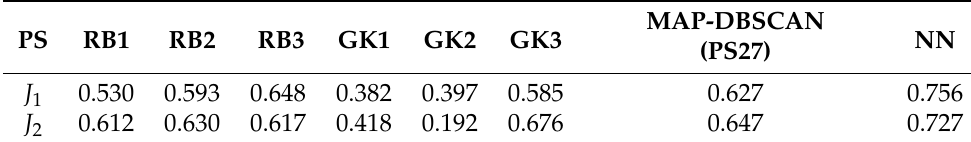
Table 2. J i , i = 1,2, values for 3 parameter sets (PS) of RB and GK algorithms, respectively, and the corresponding values of the MAP-DBSCAN and NN